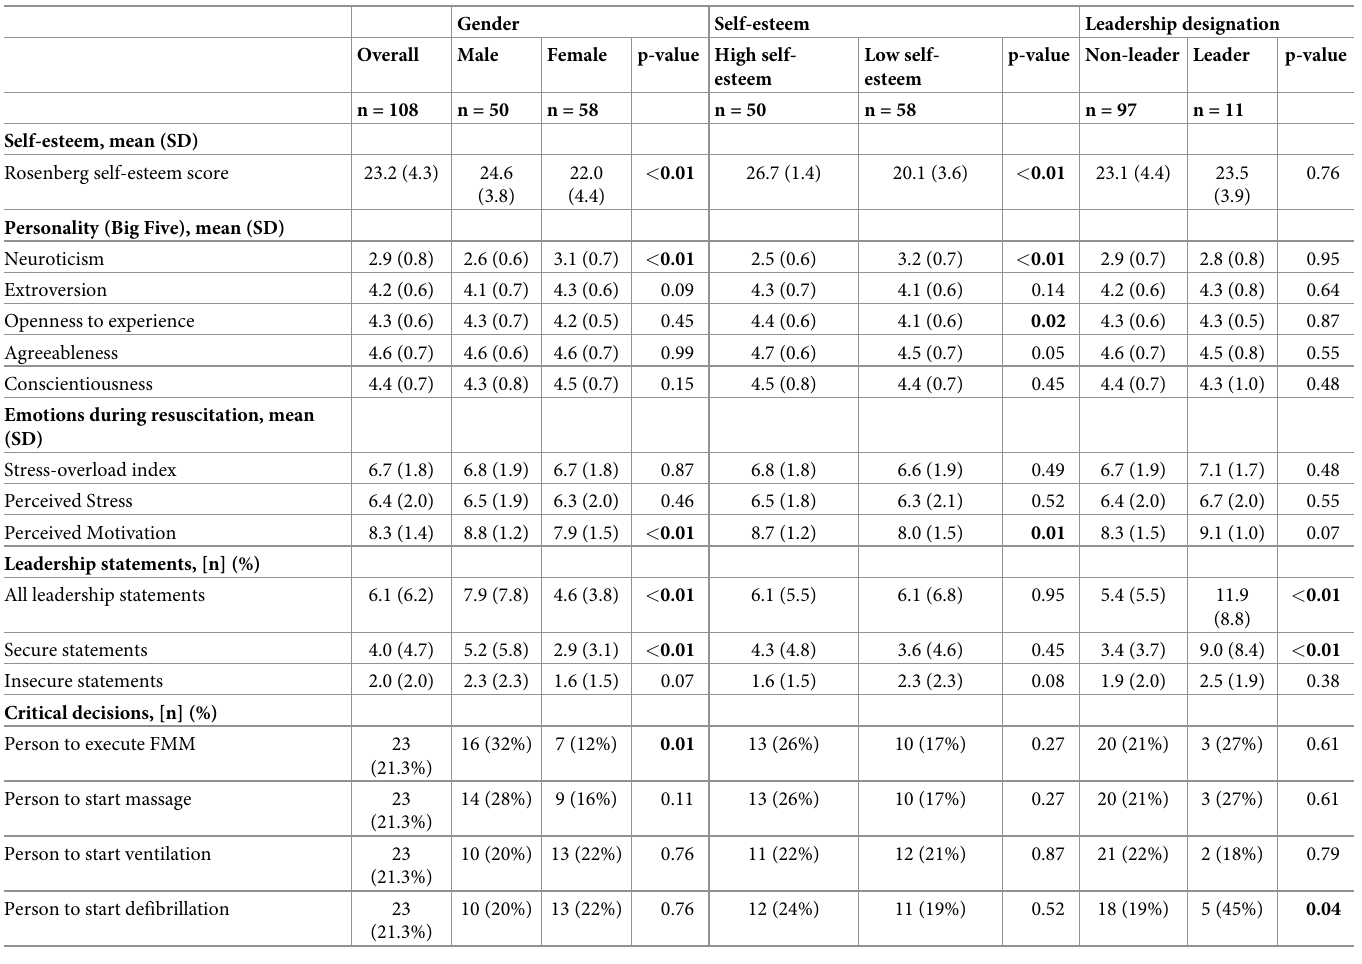
Table 4. Subgroup analysis of psychological variables of individuals and